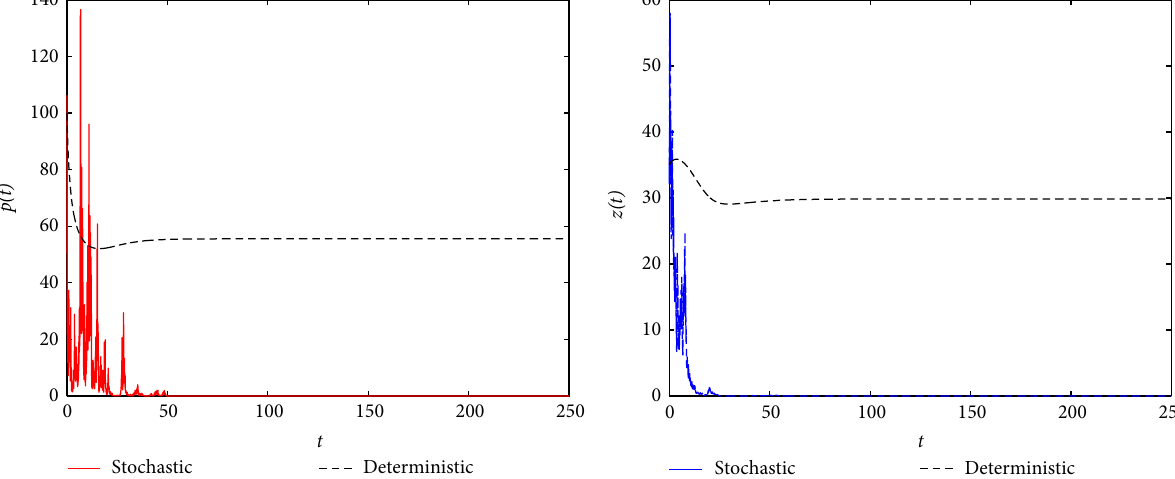
= 1.5, 𝜎 = 0.5 and other parameters are taken as 1 2